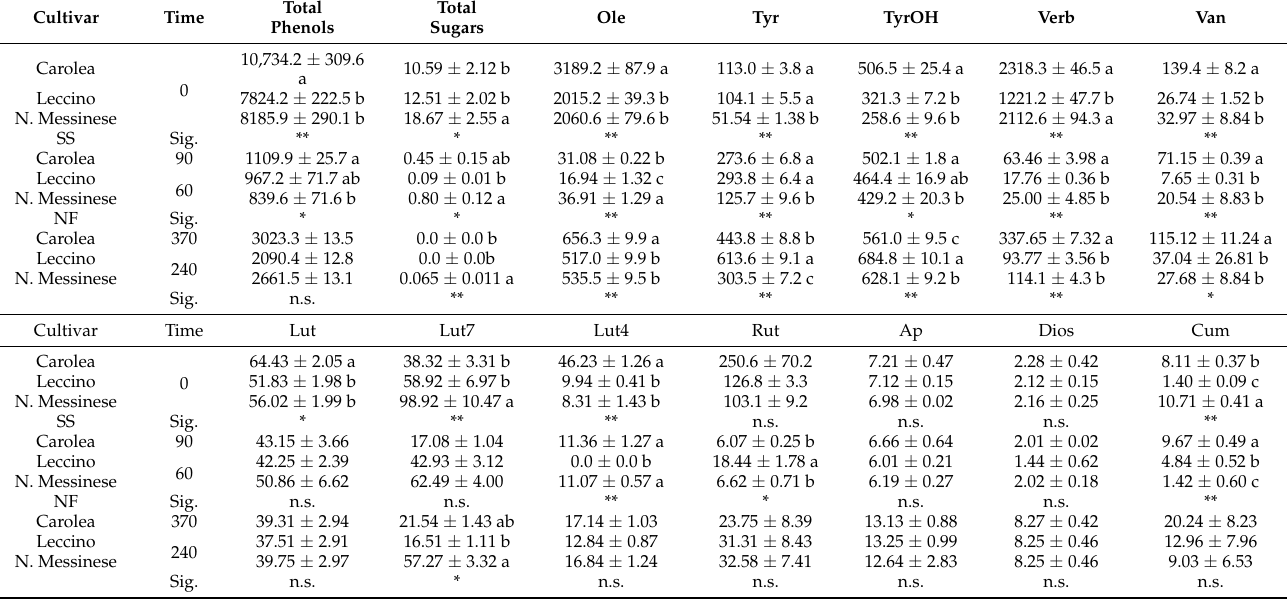
Table 4. Results of single and total phenols (mg/kg) and soluble sugars (g/100 g DW) in olive